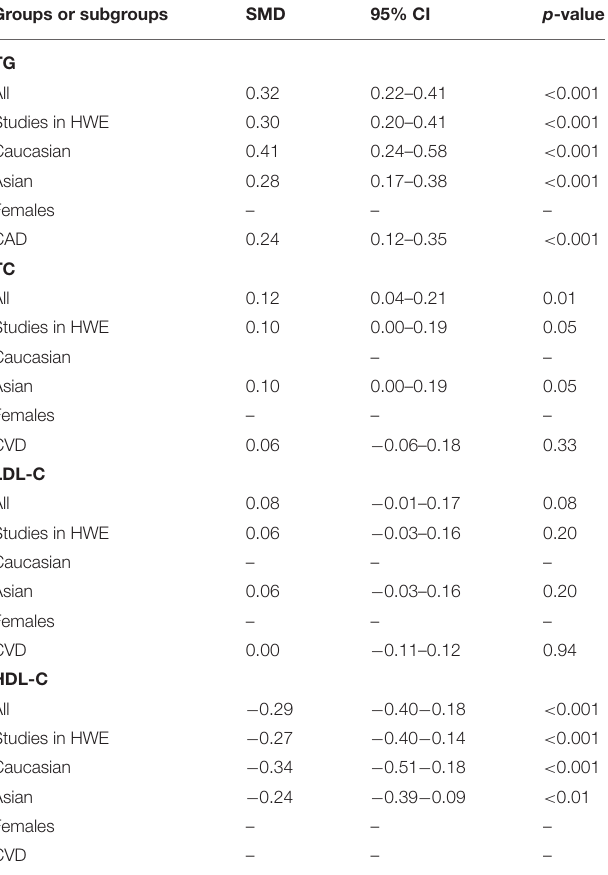
TABLE 2 | Meta-analysis of the miRNA-146a rs2910164 polymorphism with lipid levels (after excluding the study with heterogeneity). Groups or subgroups